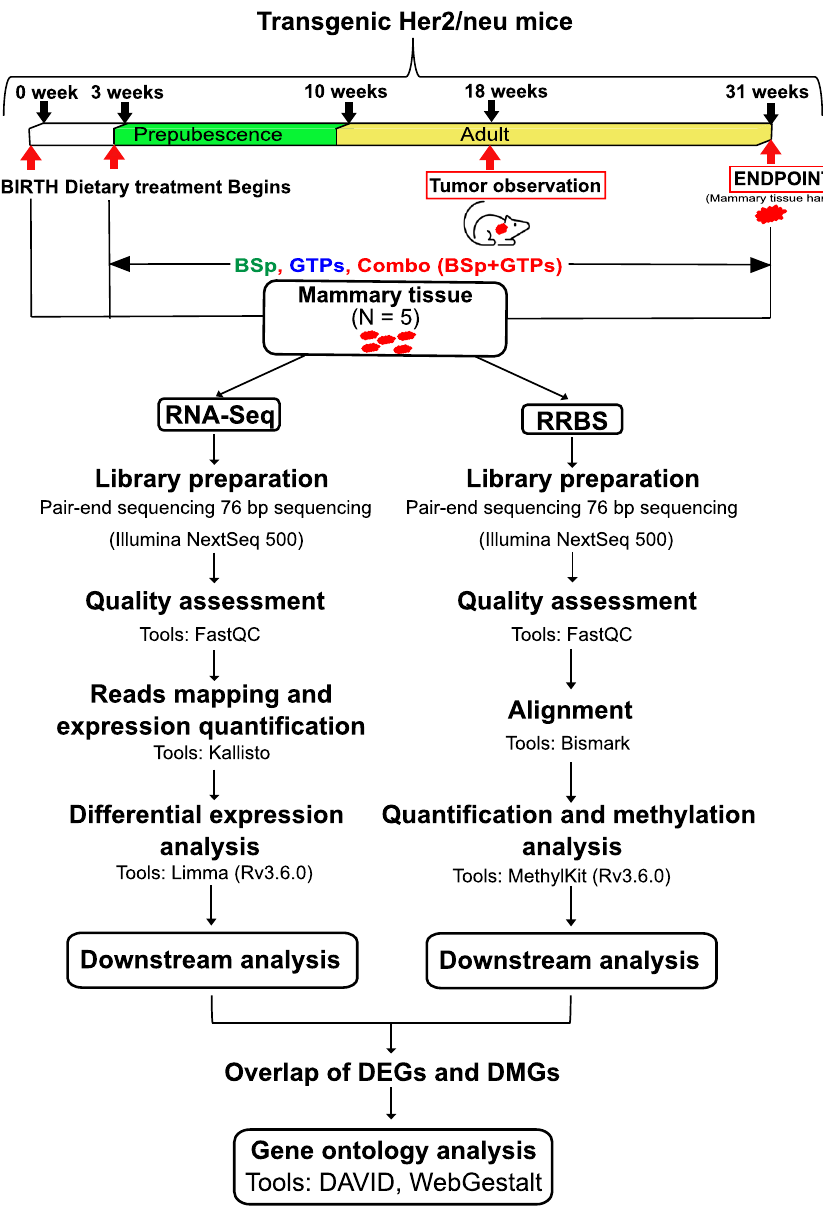
Figure 2. An overview of framework demonstrating experimental design and data analyses